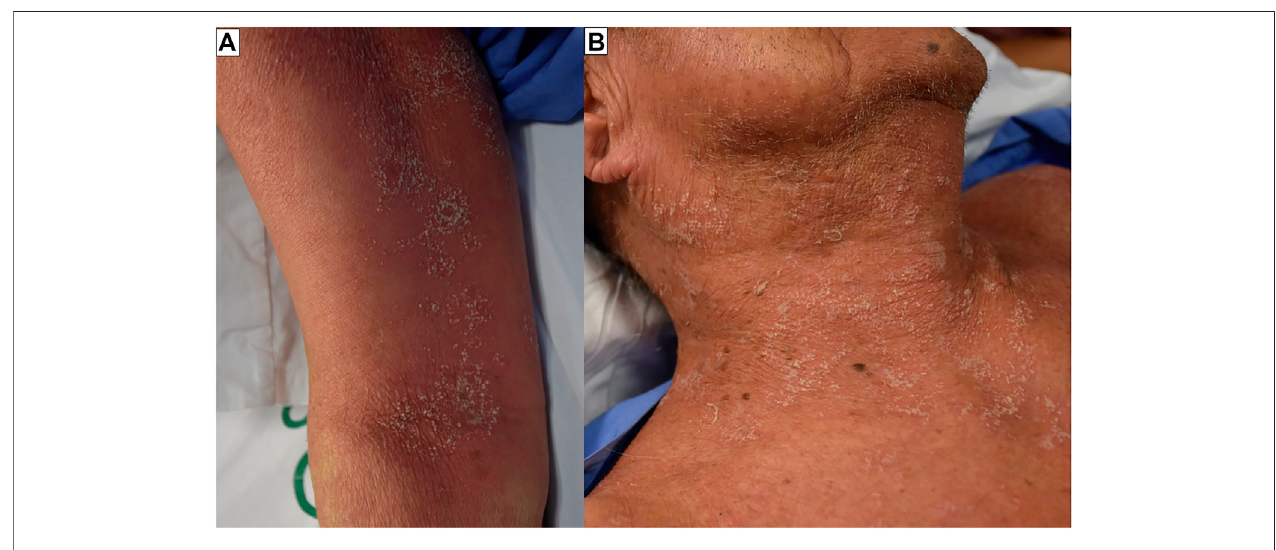
FIGURE 3 | Acute generalized exanthematous pustulosis (AGEP). Multiple pin-head sized, non-follicular pustules on edematous, homogenous, poorly demarcated, erythematous background. The lesions were found mainly on the folds of the body (A) . The pustules can become con fl uent (B)